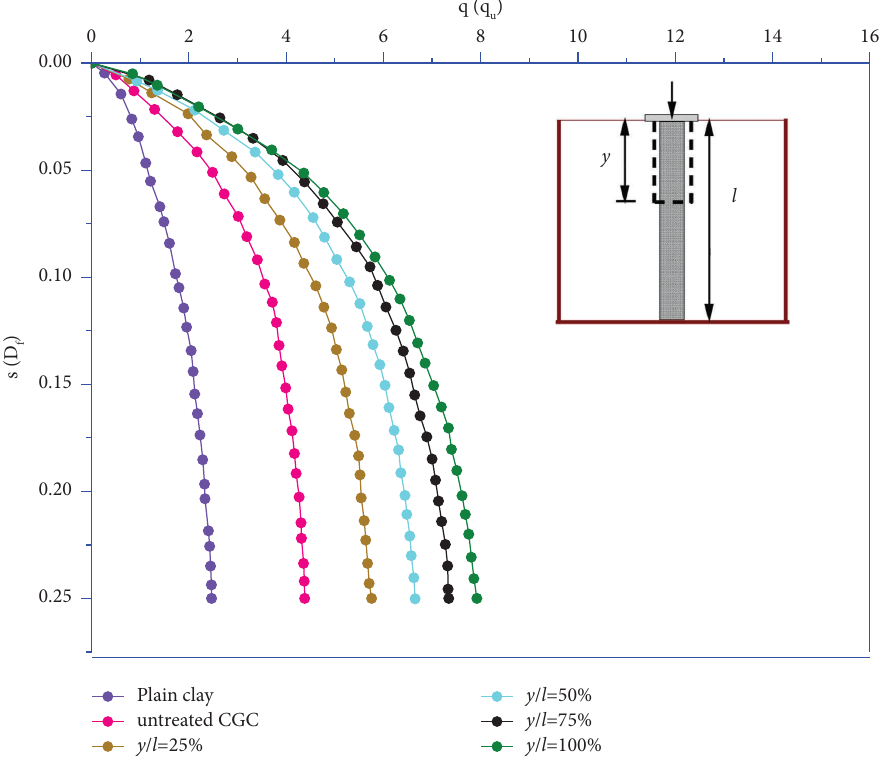
Figure 14: q / q u versus s / D f curve for various encasement